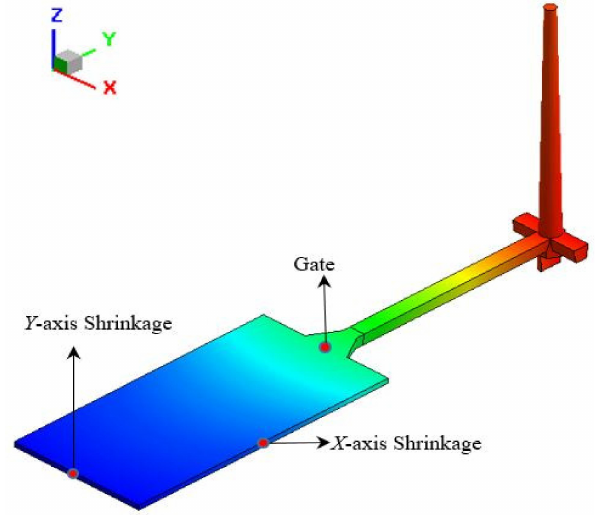
Figure 10. Model measurement position for the square